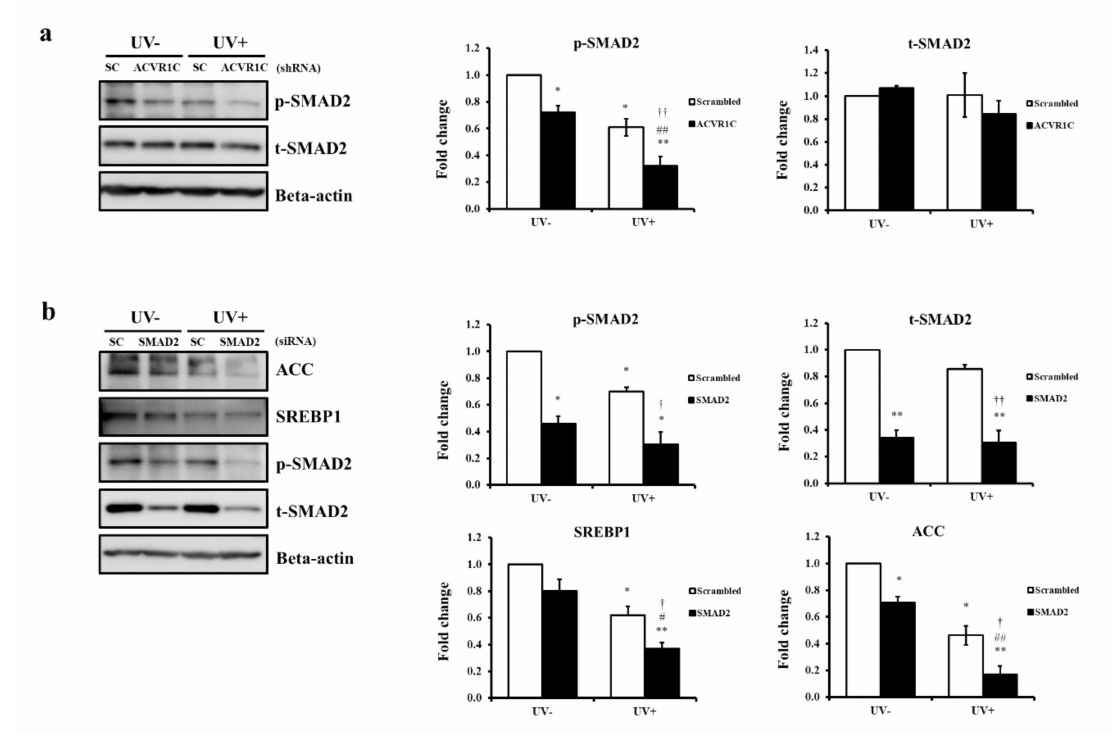
Figure 5. ACVR1C regulates the expression of SREBP1 and ACC protein via the suppression of the SMAD2 phosphorylation. ( a ) Primary NHEK were transfected with ACVR1C shRNA or scrambled control and then irradiated with UV (75 mJ/cm 2 ). SMAD2 phosphorylation was examined at 24 h after UV irradiation (n = 3) and ( b ) primary NHEK were transfected with SMAD2 siRNA or scrambled control and then irradiated with UV (75 mJ/cm 2 ). Protein levels were measured by Western blotting and quantified using ImageJ. β -actin is an equal volume of cell lysates was used as a loading control ( n = 3). * p < 0.05 and ** p < 0.01 vs. non-irradiated scrambled siRNA; # p < 0.05 and ## p < 0.01 vs. non-UV-irradiated ACVR1C shRNA or SMAD2 siRNA; † p < 0.05 and †† p < 0.01 vs. UV-irradiated scrambled shRNA or scrambled